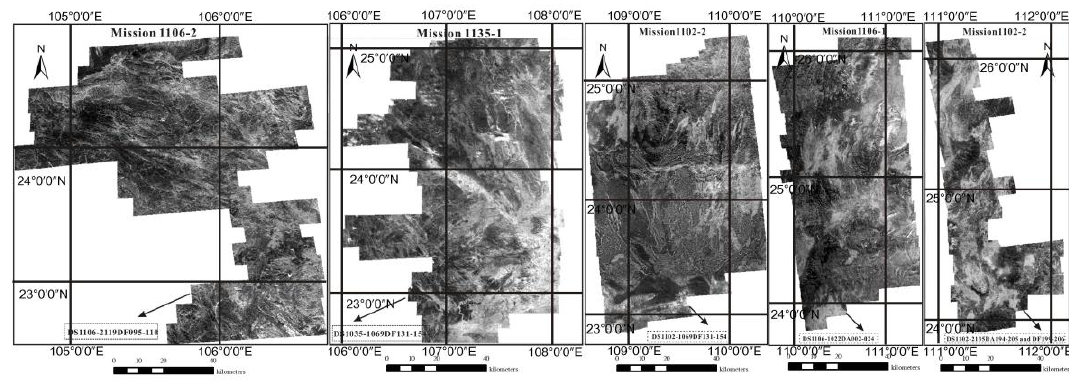
Figure 10. The mosaicked images of the various missions.